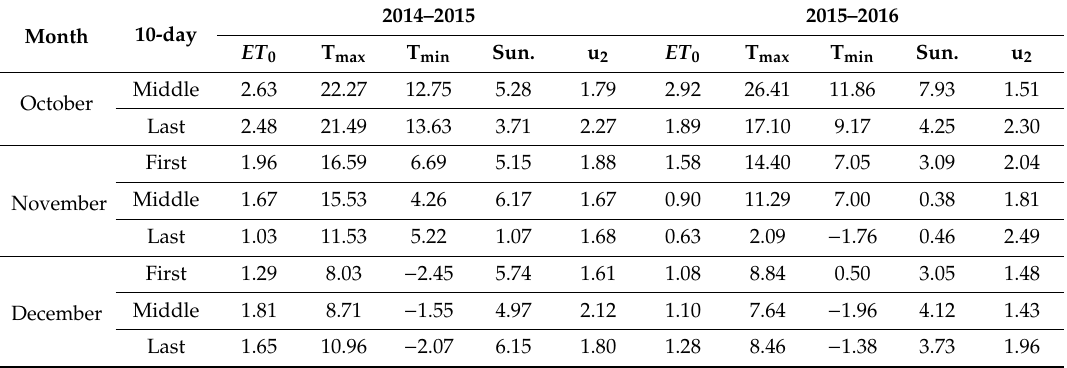
Table 1. Mean 10-day values of reference evapotranspiration ( ET 0 , mm d − 1 ), maximum temperature (T max , ◦ C), minimum temperature (T min , ◦ C), sunshine (Sun., h), and wind speed (u 2 , m s − 1 ) during the four wheat seasons from 2014 to